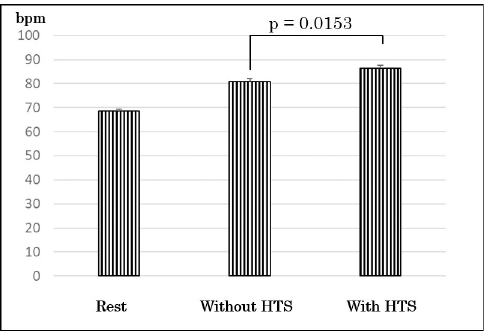
Fig 5. Comparing of changes of heart rate. HTS, hybrid training